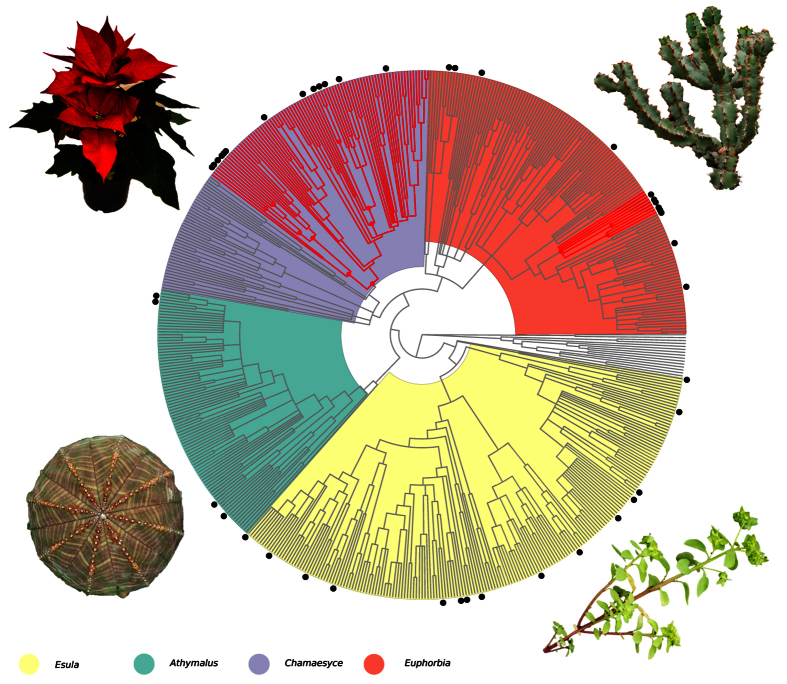
Hot nodes and corresponding clades of the category inflammatory response.Hot nodes (red dots) were identified by the nodesigl command in PHYLOCOM v4.2 on the majority consensus tree. Hot nodes indicate that the observed number of species in the category in that node is higher than expected by chance. Black dots indicate species with documented uses in the category inflammatory response. Photo: Mogens Trolle and Madeleine Ernst (Euphorbia pulcherrima).